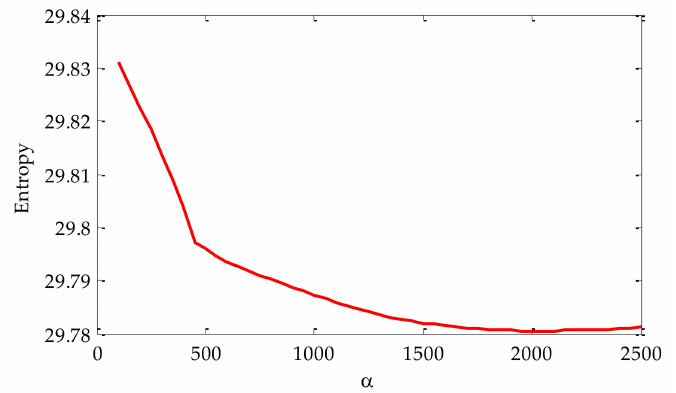
Figure 26. Curve of fitness varying with α value.